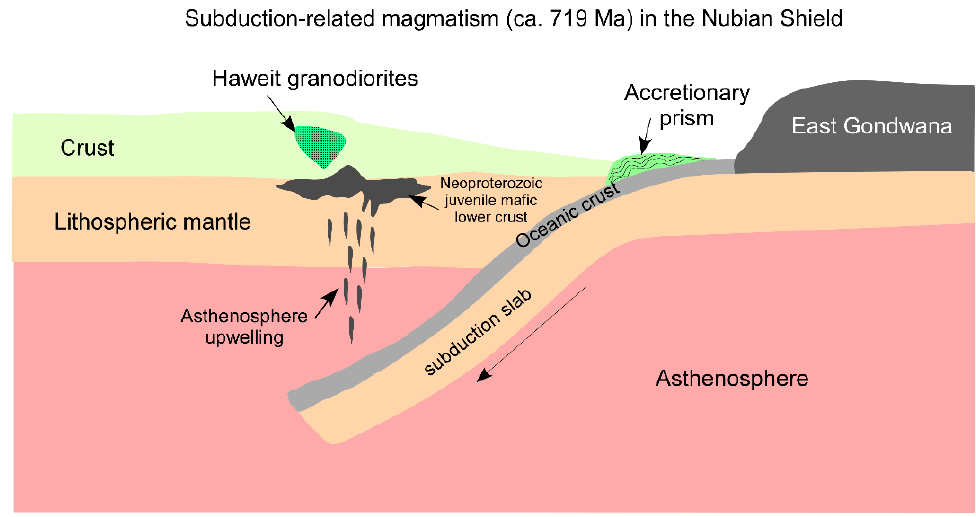
Figure 13. A sketch model shows the subduction tectonic evolution (ca. 719 Ma) of the Haweit granodiorites in Gabgaba Terrane, NE Sudan. Not to scale.